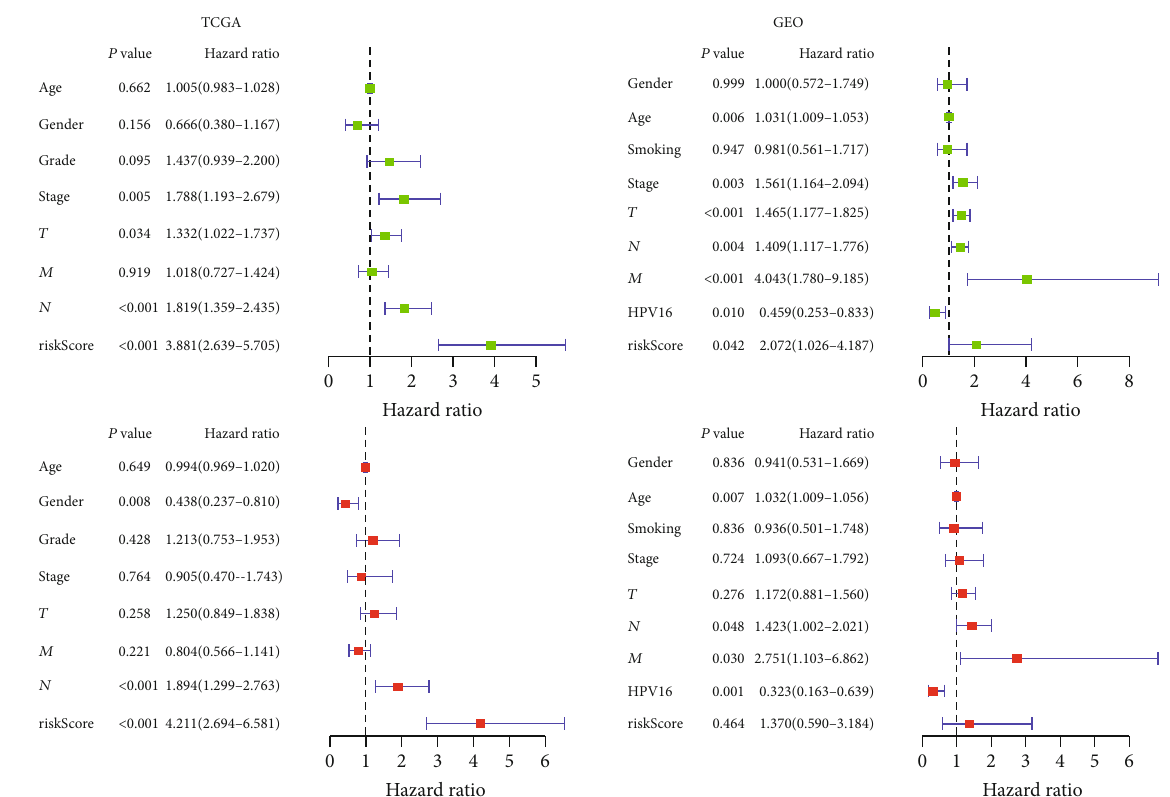
Figure 3: The result of univariate and multivariate Cox regression analysis showed that our prognostic model is an independent prognostic factor for OS.